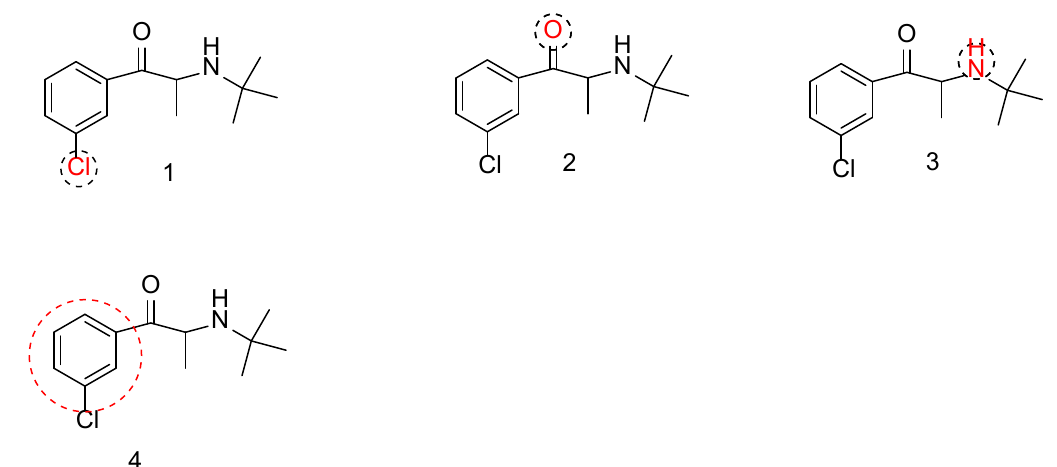
Fig. 2. Different active places in Bupropion Fig 2. Different active places in Bupropion